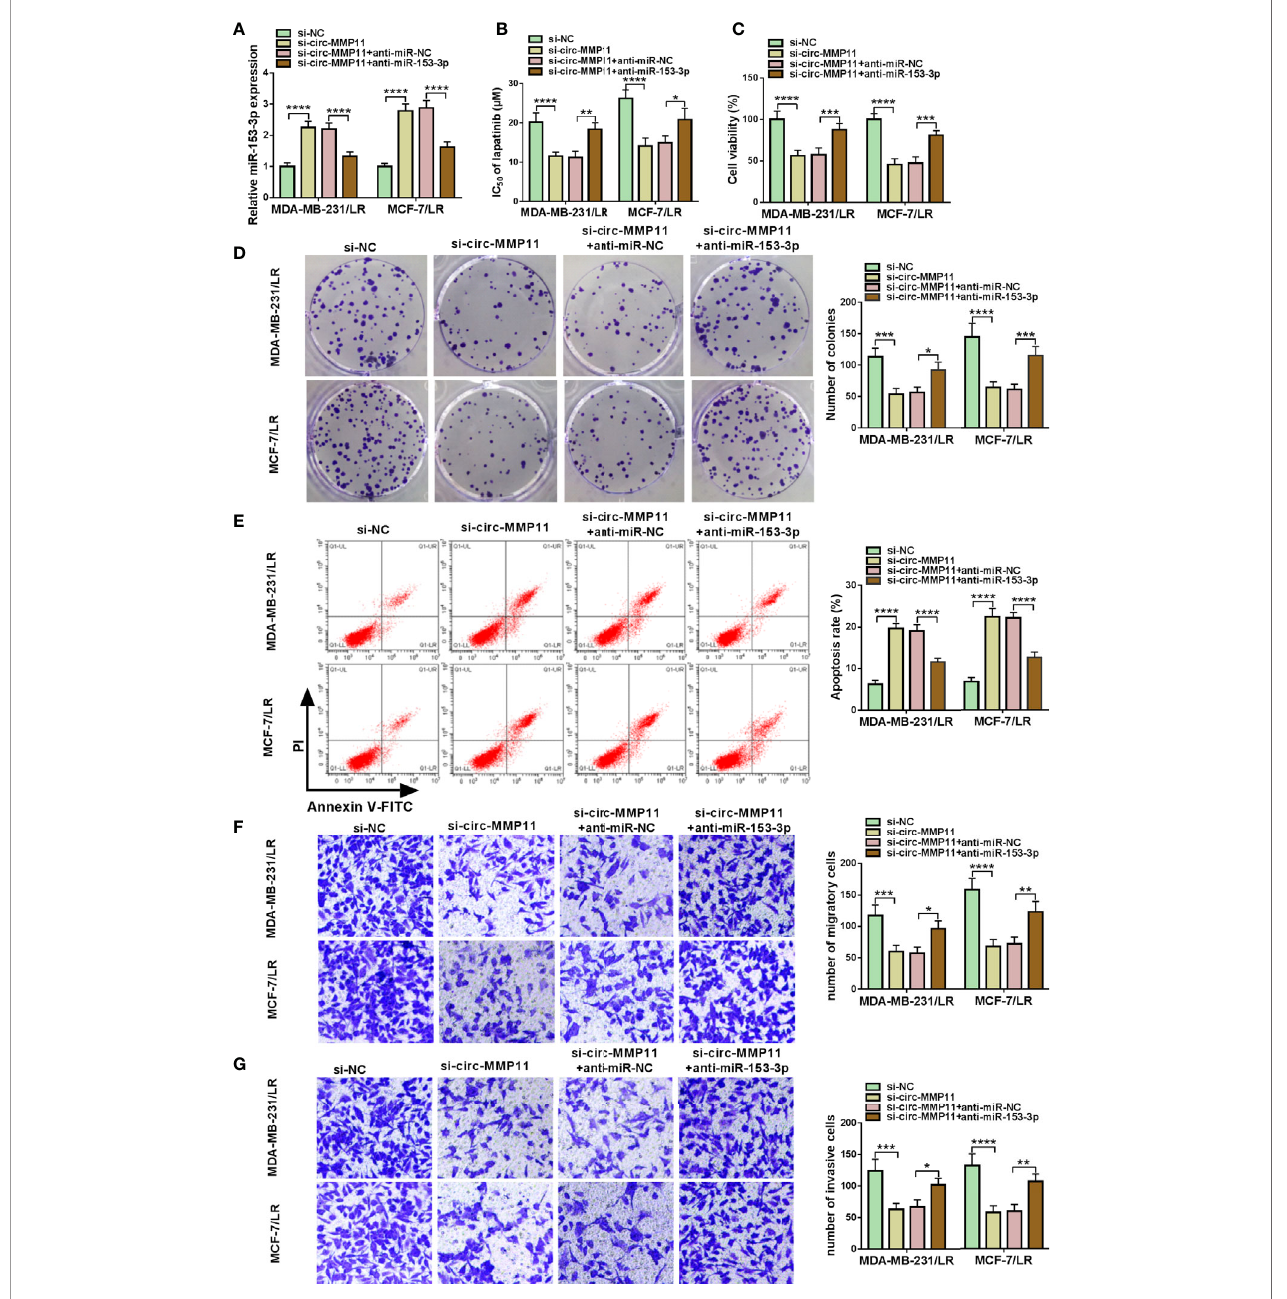
FIGURE 5 | Downregulation of miR-153-3p mitigated circ-MMP11 silencing-mediated lapatinib sensitivity in LR breast cancer cells. MDA-MB-231/LR and MCF-7/LR cells were transfected with si-NC, si-circ-MMP11, si-circ-MMP11+anti-miR-NC, and si-circ-MMP11+ anti-miR-153-3p. (A) The expression level of miR-153-3p was measured in transfected MDA-MB-231/LR and MCF-7/LR cells. (B) IC 50 value of lapatinib was detected by MTT assay in transfected MDA-MB-231/LR and MCF-7/LR cells. (C, D) Cell viability and clone number were determined by MTT and cell colony formation assays in transfected MDA-MB-231/LR and MCF-7/LR cells. (E) Apoptosis rate was evaluated by fl ow cytometry assay in transfected MDA-MB-231/LR and MCF-7/LR cells. (F, G) Abilities of migration and invasion were monitored by transwell assays in transfected MDA-MB-231/LR and MCF-7/LR cells. * P < 0.05, ** P < 0.01, *** P < 0.001, **** P < 0.0001 (ANOVA with Tukey ’ s tests), miR-153-3p relative to